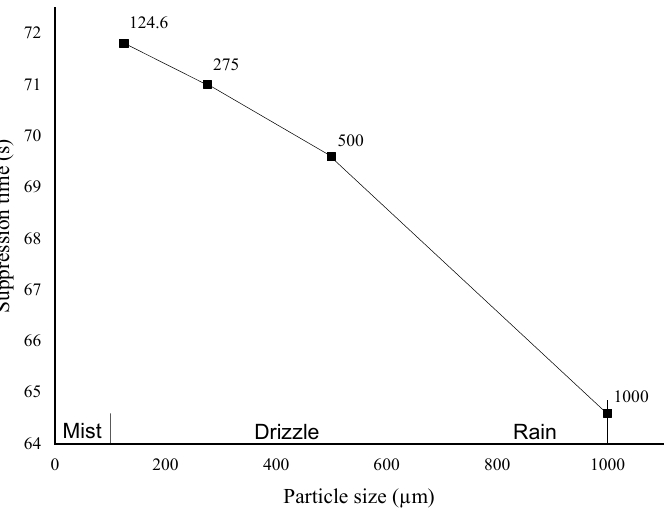
Figure 7. Comparison of the effect of the droplet on pool fire suppression based on the heat release rate.